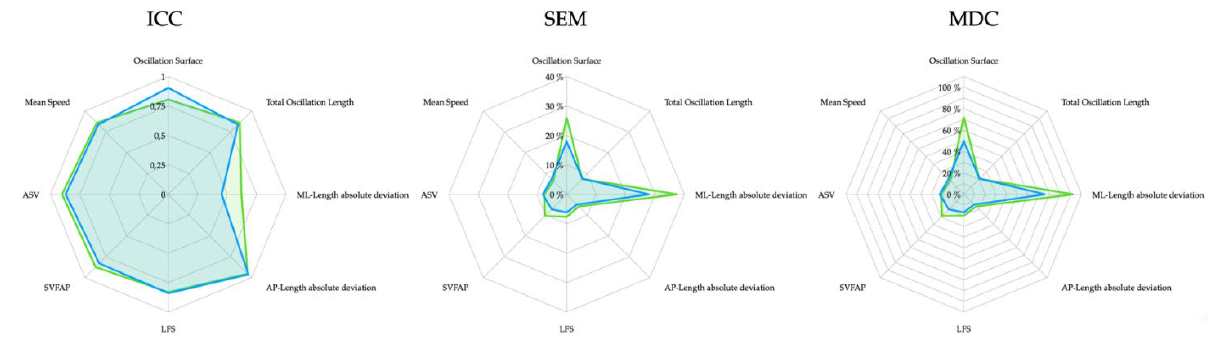
Figure 3. ICC 2,1 , SEM% and MDC 95 % scores for 35–40 dB (blue) and 85–90 dB (green). Table 3 describes how calculating the mean average of 2 or 3 measurements results in comparable scores for both acoustic conditions ( p > 0.05). Table 3. Score differences between number of trials (2 and 3 mean average scores) for each acoustic condition (35–40 and 85–90